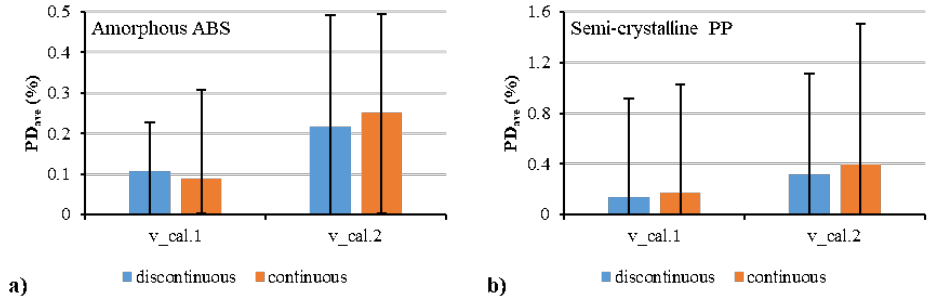
Figure 11. Average absolute percentage deviations between the specific volume calculated by different models and the additional experimental specific volume at two isobaric levels of 1400 and 1000 bar: amorphous ABS ( a ) and semi-crystalline PP ( b ). amorphous ABS ( a ) and semi-crystalline PP ( b